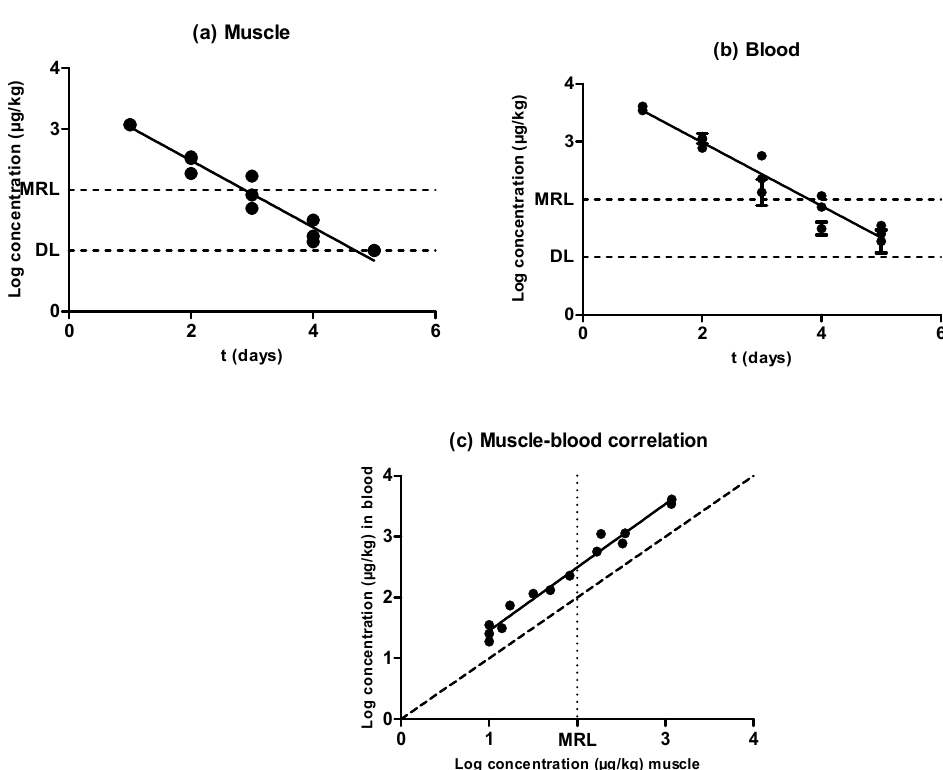
Figure 2. Evolution of the concentration of sulfamethoxypyridazine in muscle ( a ) and blood ( b ) samples obtained from pigs treated with sulfamethoxypyridazine and slaughtered at preset intervals within the withdrawal period, determined by LC–MS / MS. The DL dotted line represents the detection limit of the analytical technique for sulfamethoxypyrydazine, and the MRL dotted line represents the maximum residue limit of sulfamethoxypyrydazine in muscle as established by Regulation (EEC) No. 2377 / 90. Relationship among the concentrations of sulfamethoxypyridazine detected in blood and muscle samples ( c ). The bisecting dotted line represents the 1:1 correlation if both matrixes contained the same concentration of